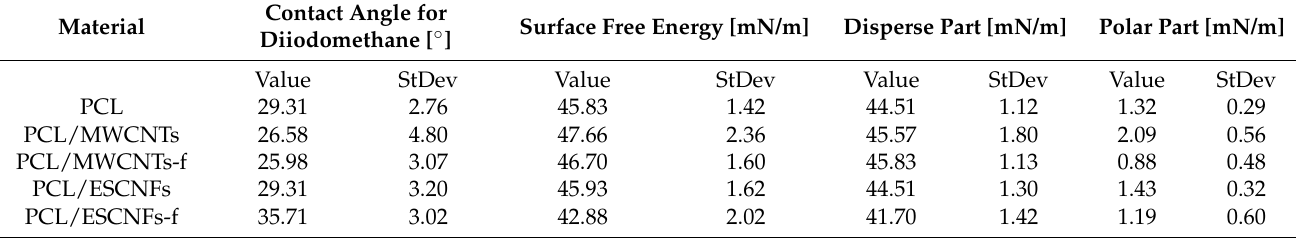
Table 1. Contact angle for diiodomethane and surface free energy for the top surfaces (the contact surface with the U-2 OS cells) of the studied